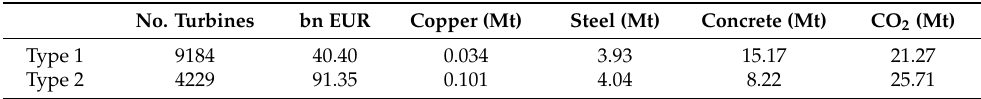
Table A5. Demand for green hydrogen (90 TWh) in terms of onshore/offshore turbines. No. Turbines bn EUR Copper